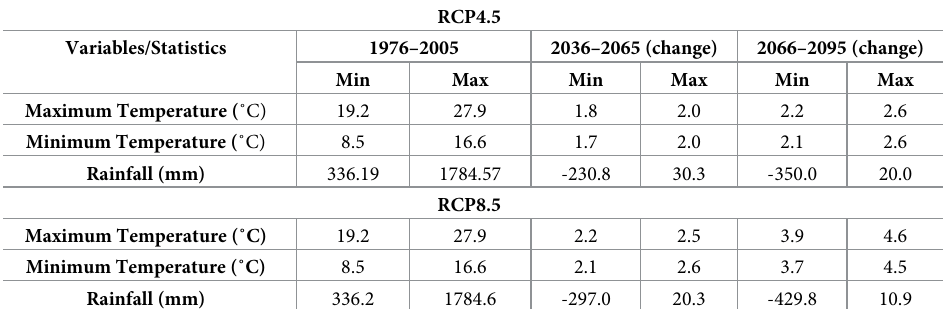
Table 7. Summary of historical and projected changes in mean maximum temperature, minimum temperature, and total rainfall for 2036–2065 and 2066–2095 periods under RCP4.5 and RCP8.5 scenarios relative to the base- line period 1976–2005 over the Olifants River